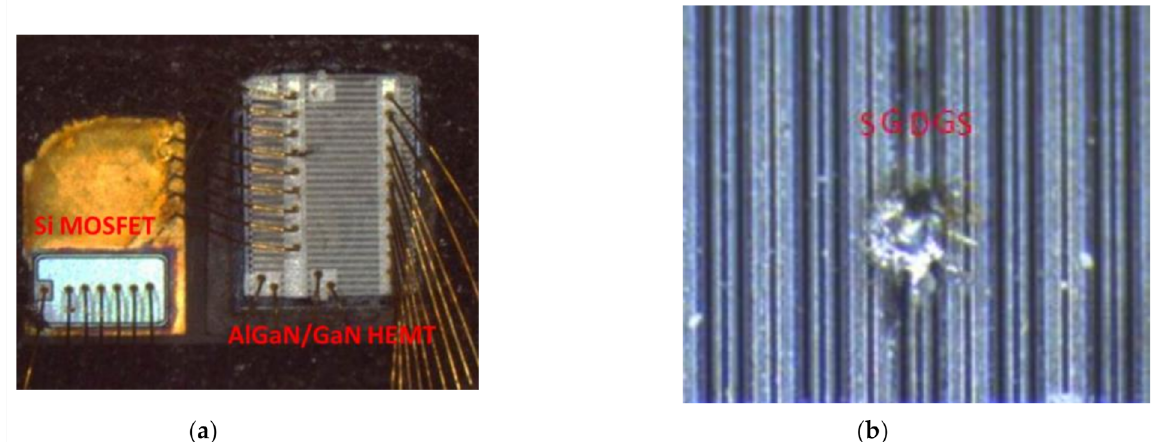
Figure 16. ( a ) The cascode AlGaN/GaN HEMT under test and ( b ) the picture of the device after heavy-ion